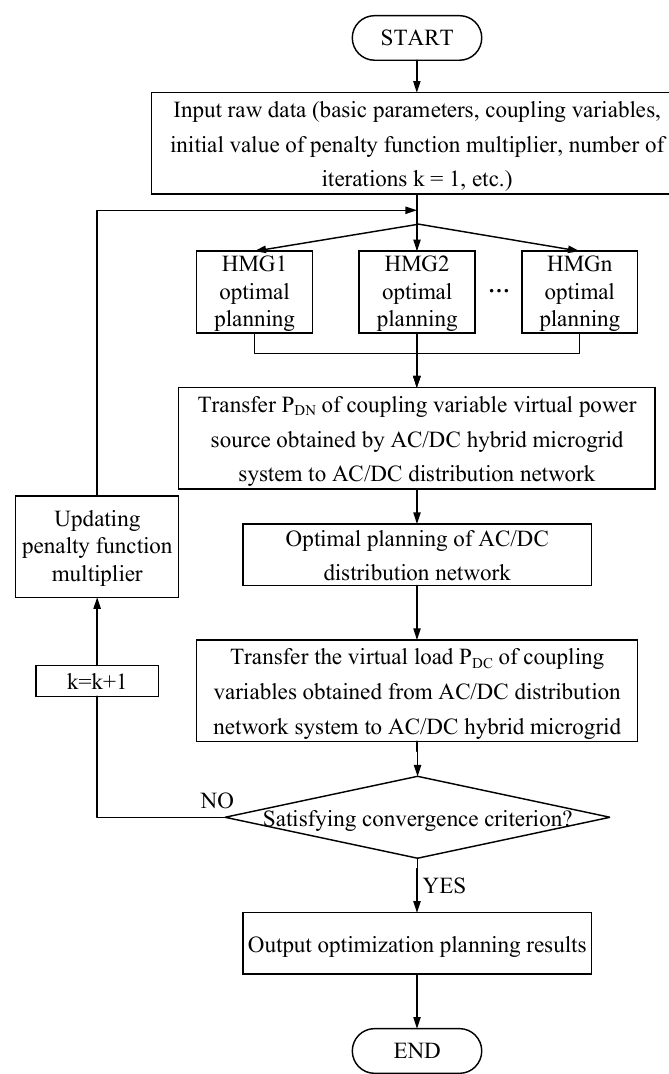
Figure 4. Cooperative planning process of a microgrid and distribution system based on ATC